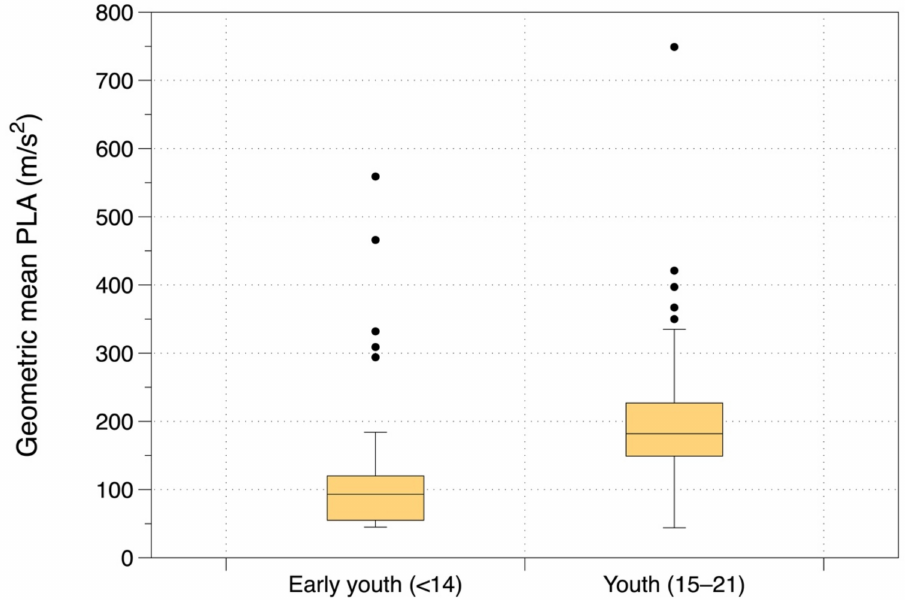
Figure 6. Geometric mean PLA from observational studies subdivided by